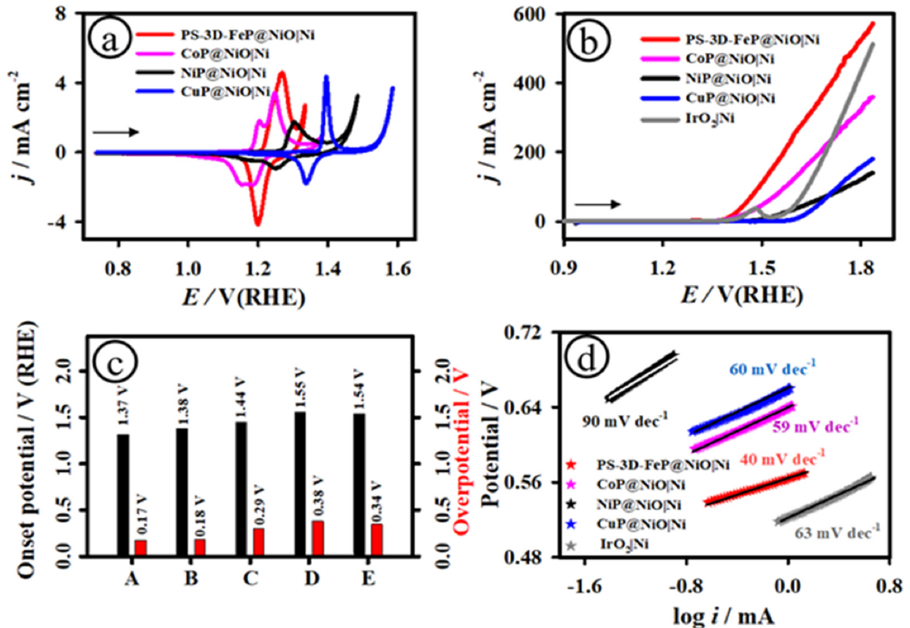
Figure 6. CV ( a ) and LSV ( b ) curves of the various electrodes including PS ‐ 3D ‐ FeP@NiO|Ni (red curve), CoP@NiO ǀ Ni (pink curve), NiP@NiO ǀ Ni (black curve), and CuP@NiO ǀ Ni (blue curve) electrodes recorded in 1.0 M KOH at the scan rate of 20 mVs − 1 . (The arrow indicates the potential cycle started) ( c ) The plot of onset potentials ( E onset ) and overpotential measured at 10 mA cm − 2 for PS ‐ 3D ‐